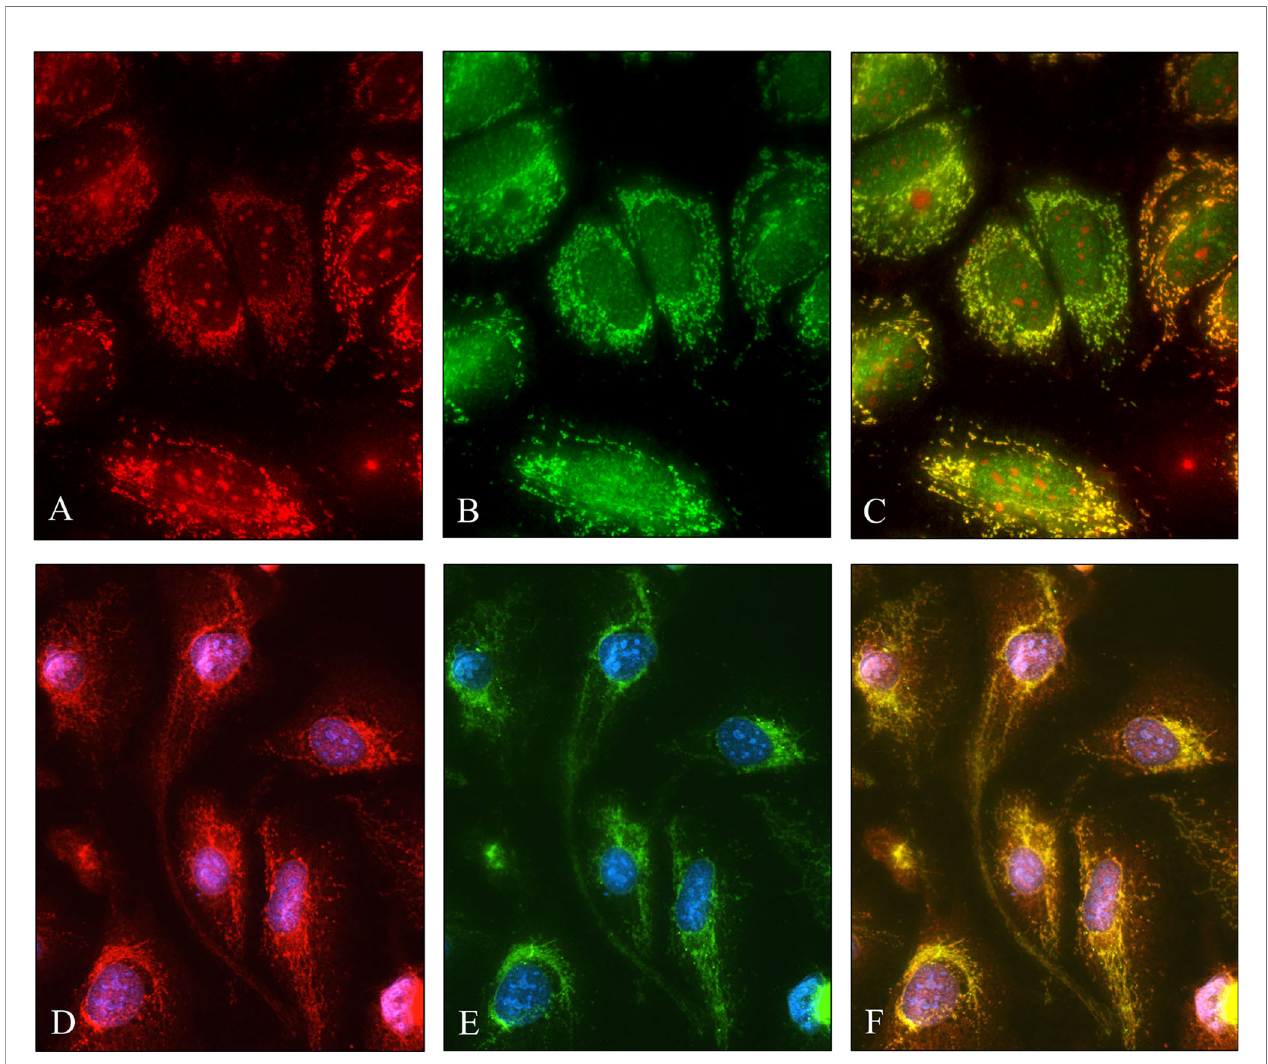
FIGURE 6 | Colocalization of SPOCK1 with a mitochondrion marker and TOMM20 mitochondrial protein. (A) Staining of HuH7 hepatoma cells with MitoTracker. (B) SPOCK1 alone. (C) The MitoTracker-red and SPOCK1 (green) stainings are aligned. (D, E) Immunostaining of HLE cells with SPOCK1 (red) and TOMM20 (green); the two proteins are fully aligned (F) . Original magni fi cation,